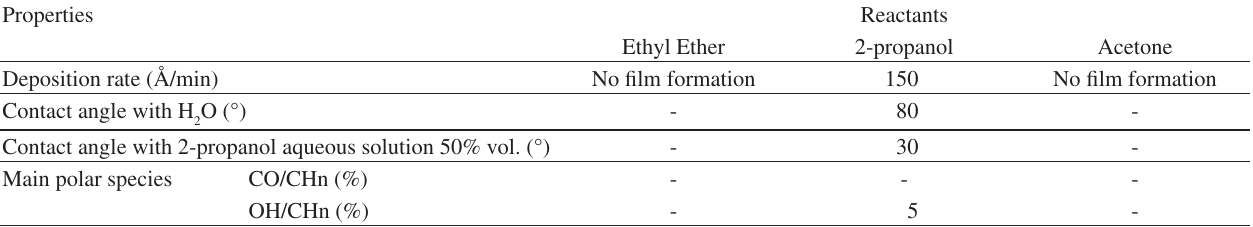
Table 3. Deposition conditions and most important characteristics obtained for plasma deposition of ethyl ether, 2-propanol and acetone in silicon substrates using tubular reactor powered with 13.56 MHz.